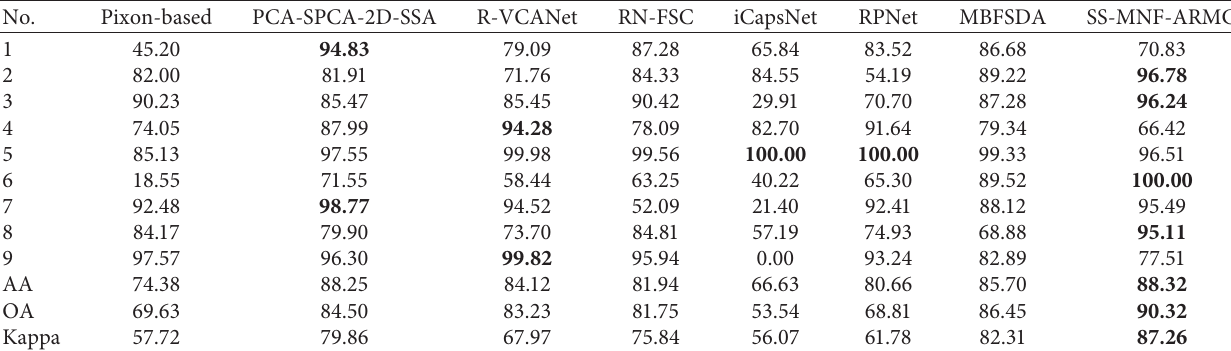
Table 6: Classification results of different techniques for the Pavia University dataset (9 classes).